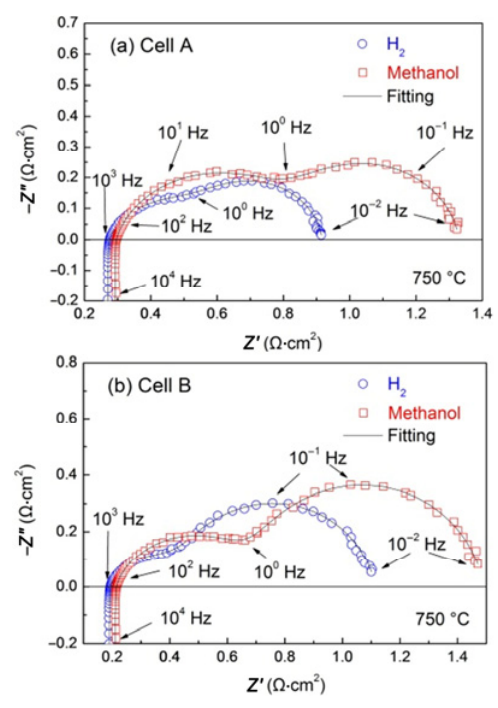
Fig. 6 Nyquist plots of single cells in hydrogen and methanol under the OCV condition: (a) anode-supported single cell with a thin catalyst layer and (b) anode- supported single cell with an independent catalyst layer.